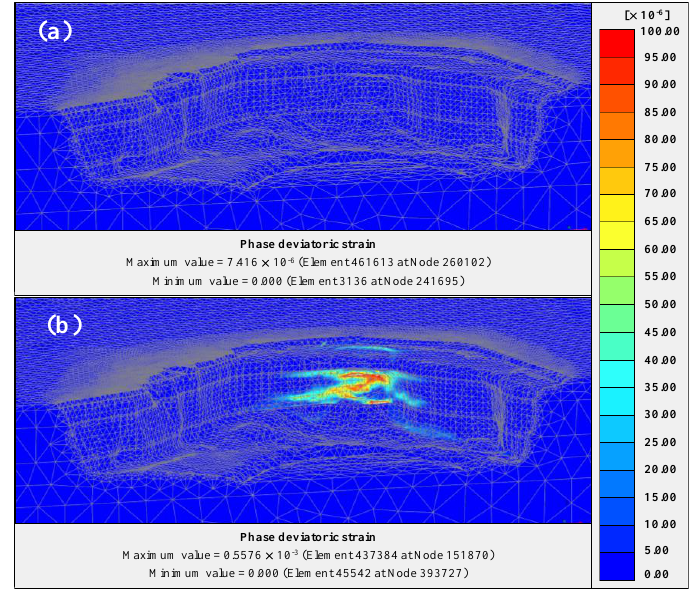
Figure 10. Deviatoric strains obtained from plastic phases: ( a ) pre- and ( b ) post- rock block detachment.